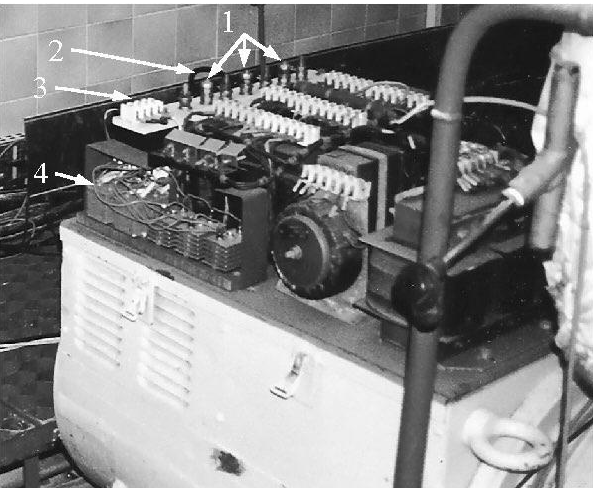
Figure 3. The WS 60 N voltage regulator with the current and voltage measuring points marked.